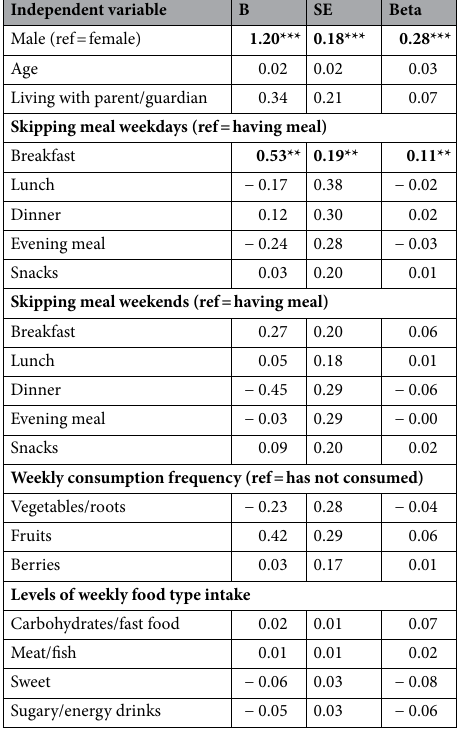
Table 4. Linear regression analysis using the enter method with the extent of digital gaming time as the dependent variable. R 2 = 0.129, Adjusted R 2 = 0.104, p = level of significance (* p < 0.05, ** p < 0.01, *** p < 0.001). Significant values are in